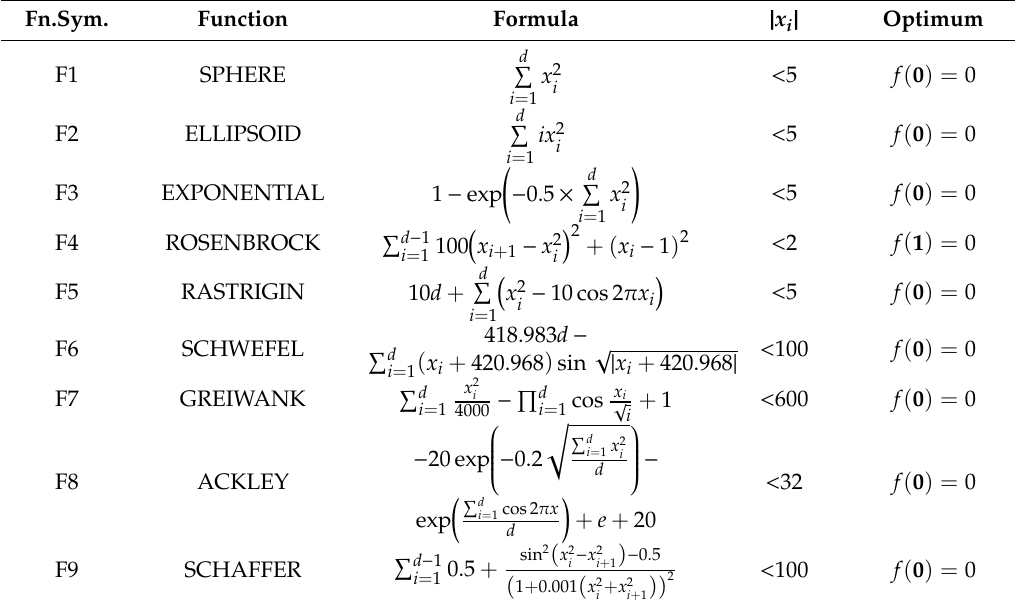
Table 1. List of nine benchmark test functions used in global optimization.